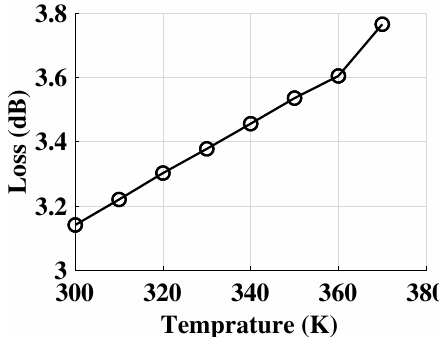
Figure 7. The effect of temperature change on propagation loss in